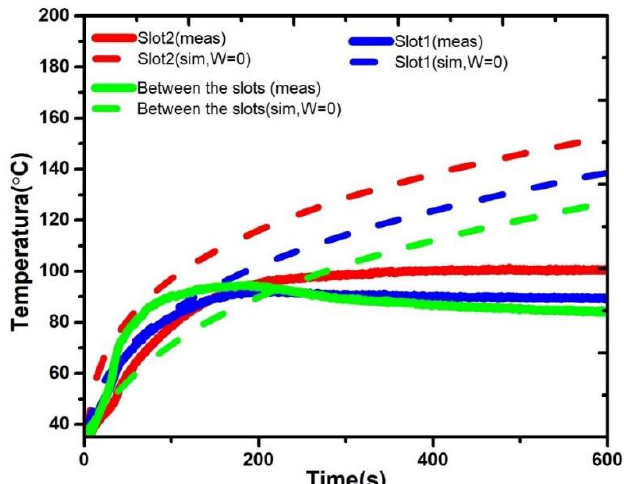
Figure 4. Temperature profiles obtained by the simulation (sim) versus temperature profiles ob- tained by the measurements from the experimentations (meas) for the double slot antenna with 5 cm of antenna